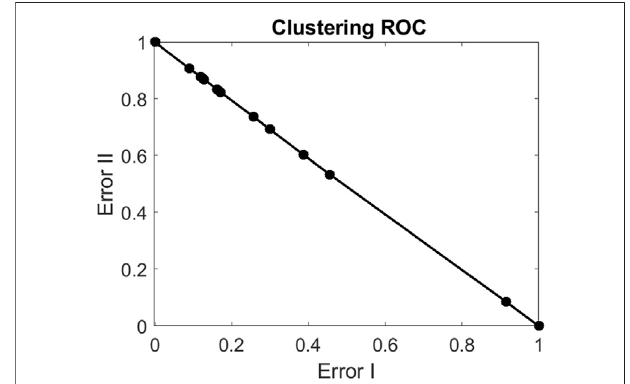
FIGURE 4 | Receiver Operating Curve (ROC) for different cluster sizes. Error I is the probability that two instances with the same slide class are in different clusters. Error II is the probability that two instances from different